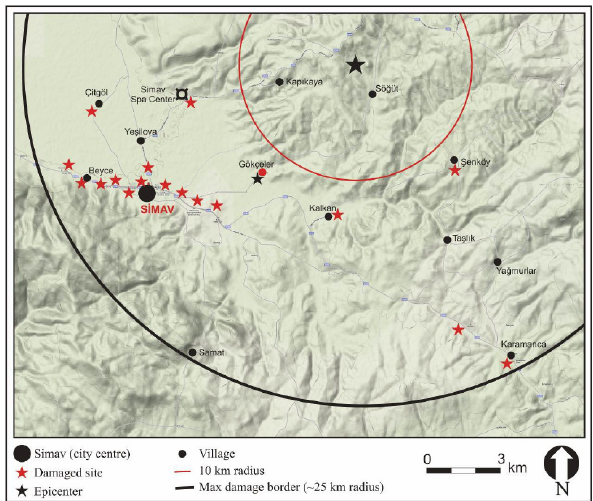
Fig. 5. Distribution of damaged areas in and around Simav (Inel et al.,